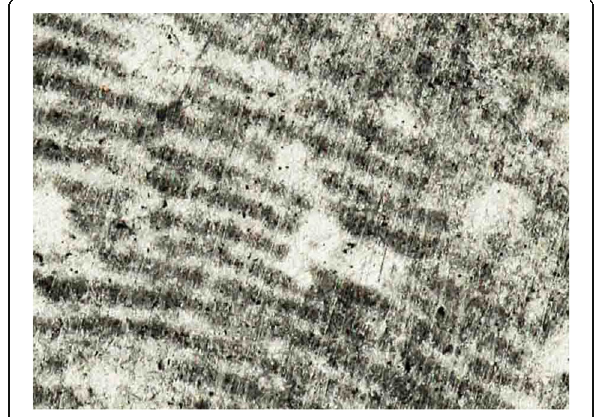
Fig. 7 The abrasion of ridge detail observed on developed fingermarks after powder dusting due to soil